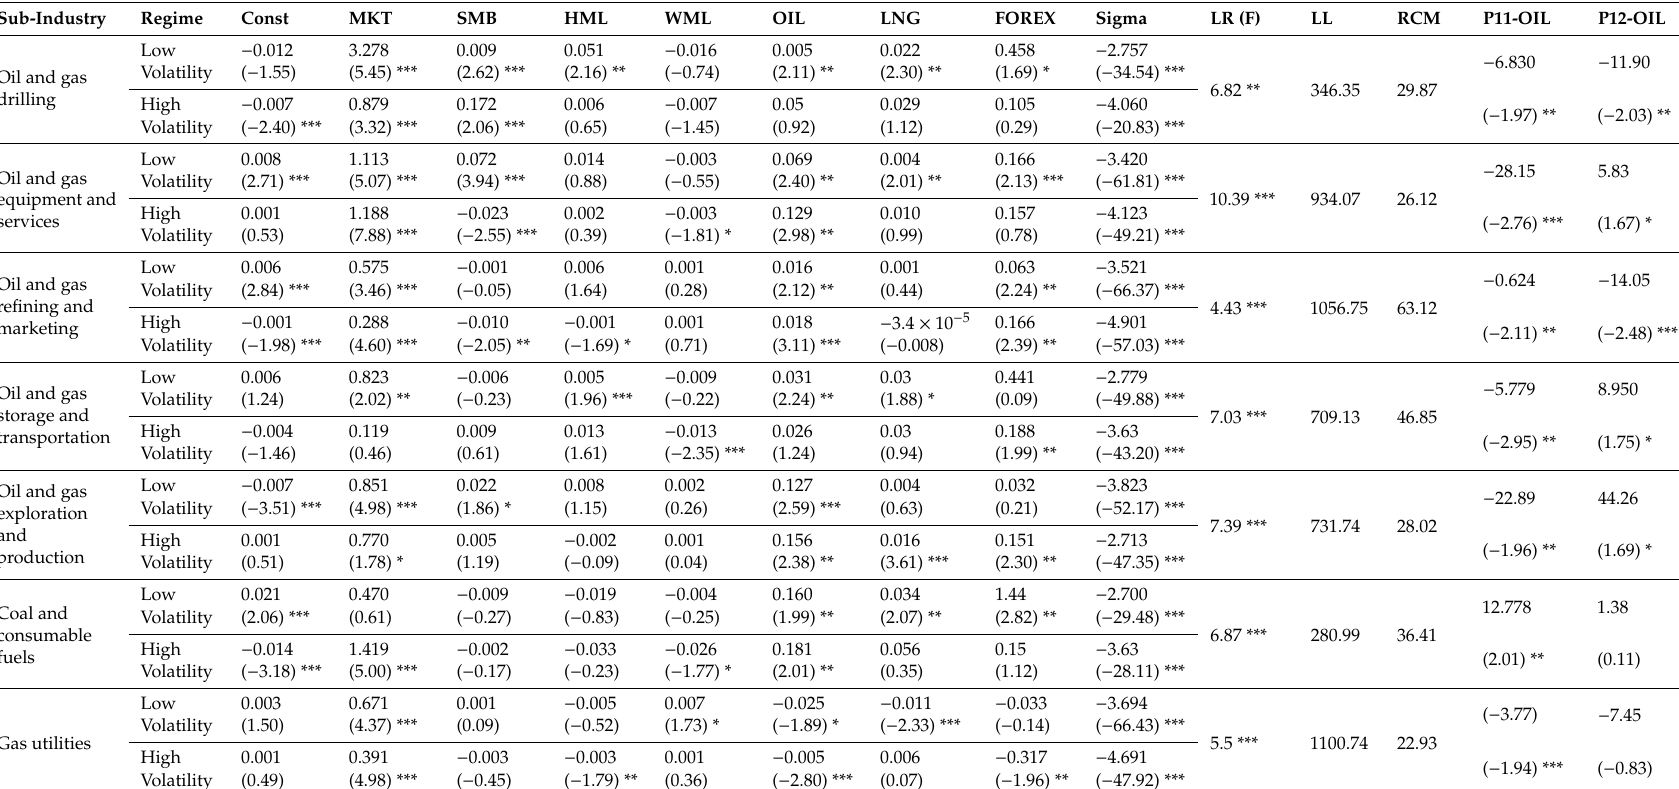
Table 5. Results for regime variable e ff ects of oil and gas